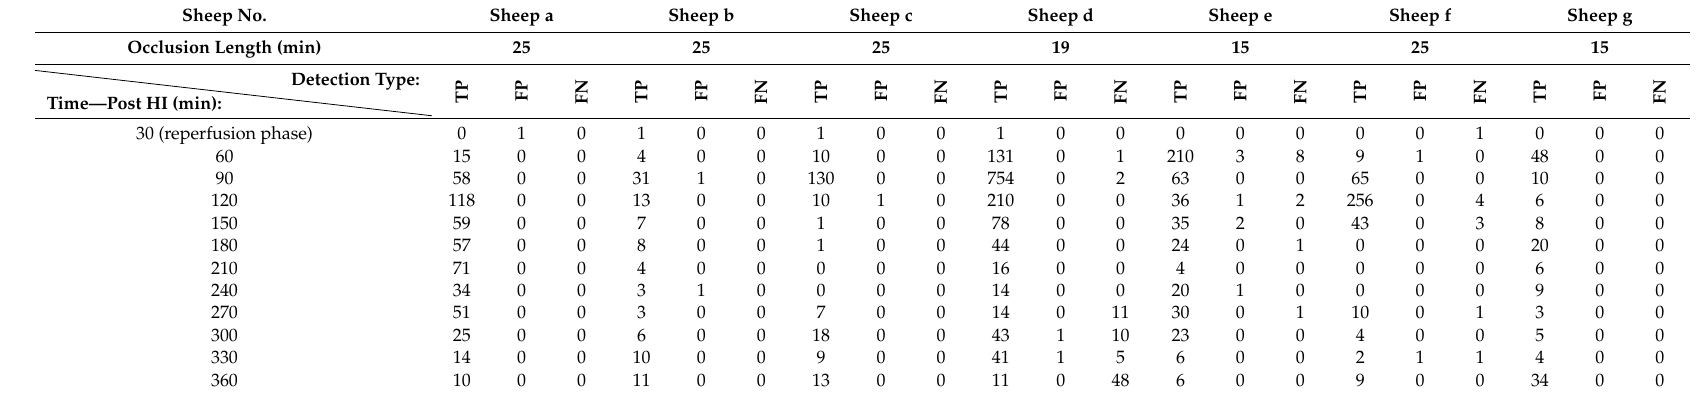
Table 3. Performance records (TP, FP, and FN hits) of the FFT-Type-1 Fuzzy classifier over the best threshold value in seven preterm fetal sheep. TP: true positive, FP: false positive, FN: false